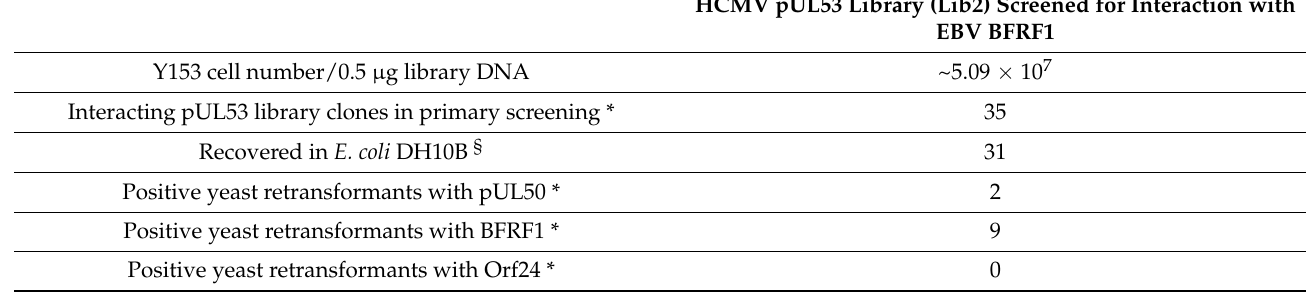
Table 2. Screening procedure to identify pUL53 clones from Lib2 that exert shared-hook binding activity in the Y2H